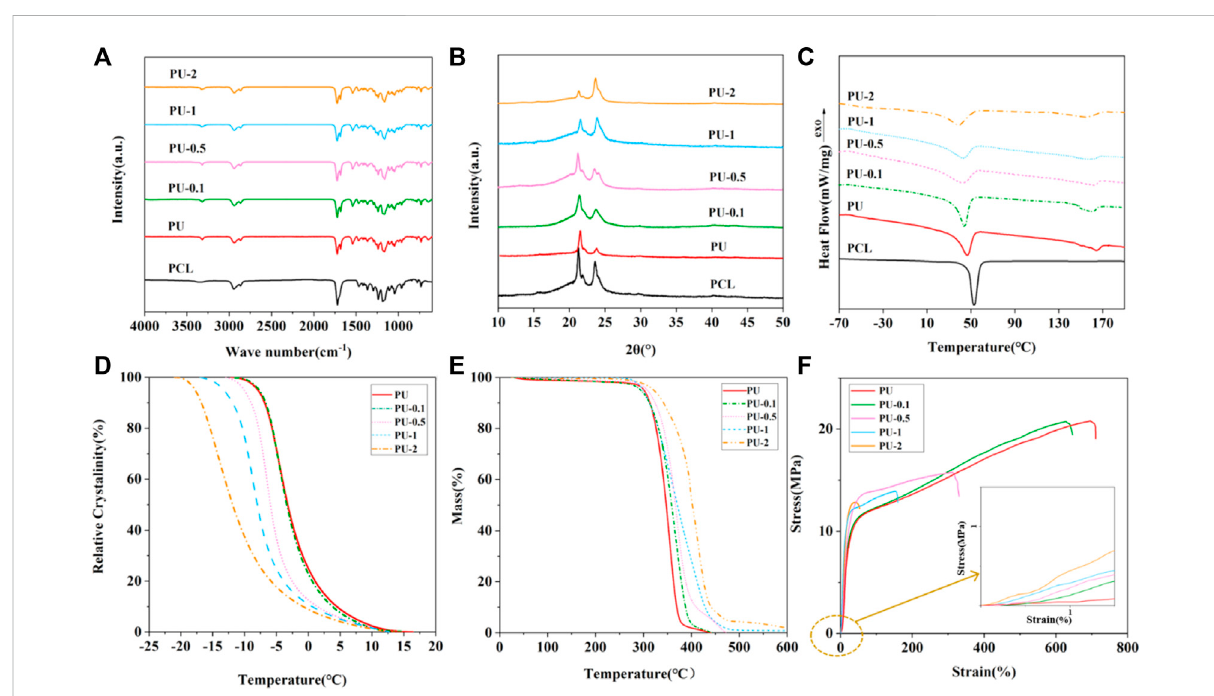
FIGURE 3 (A) FT-IR, (B) XRD,and (C) DSCcurvesofPCL,SMPU,andSMPU/i-MWCNTcompositeswithvariousi-MWCNTcontents. (D) Relativecrystallinity evolution versus temperature, (E) TG curves, and (F) stress-strain behaviors of SMPU and SMPU/i-MWCNT composites with various i-MWCNT contents at